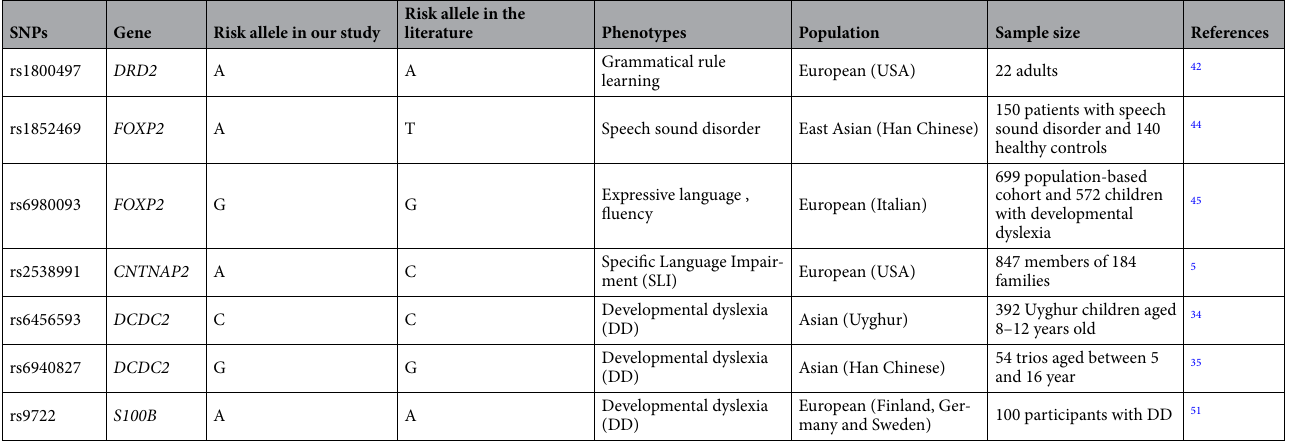
Table 7. Risk alleles of SNPs that were reported to be linked with language abilities in the present and in the